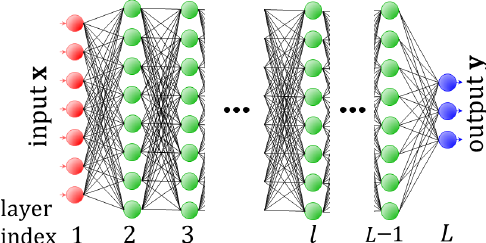
Figure 4. Neural network. Neurons are depicted as small circles and synaptic connections as straight lines. The network has an input layer (red), hidden layers (green), and an output layer (blue). Since the network shown has multiple hidden layers, it is a deep neural network.